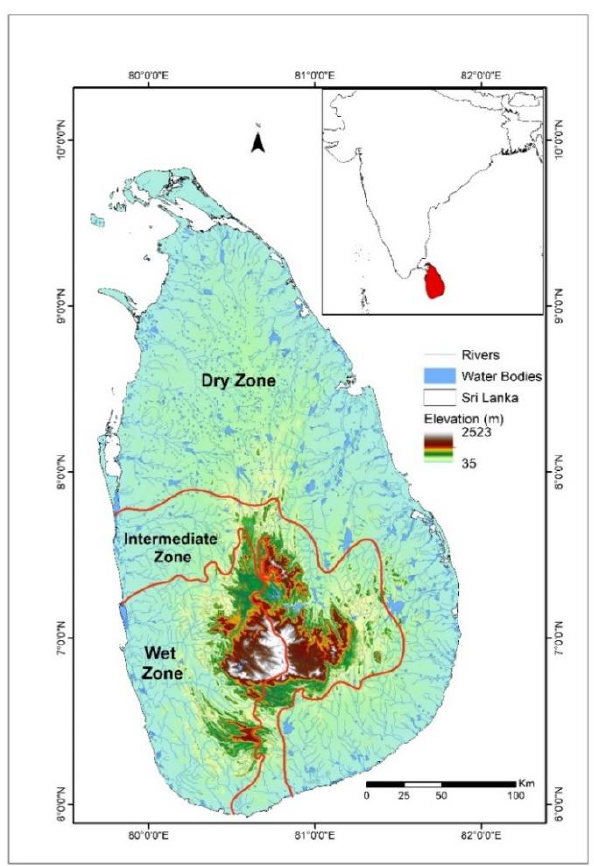
Figure 1. The location of the study area.